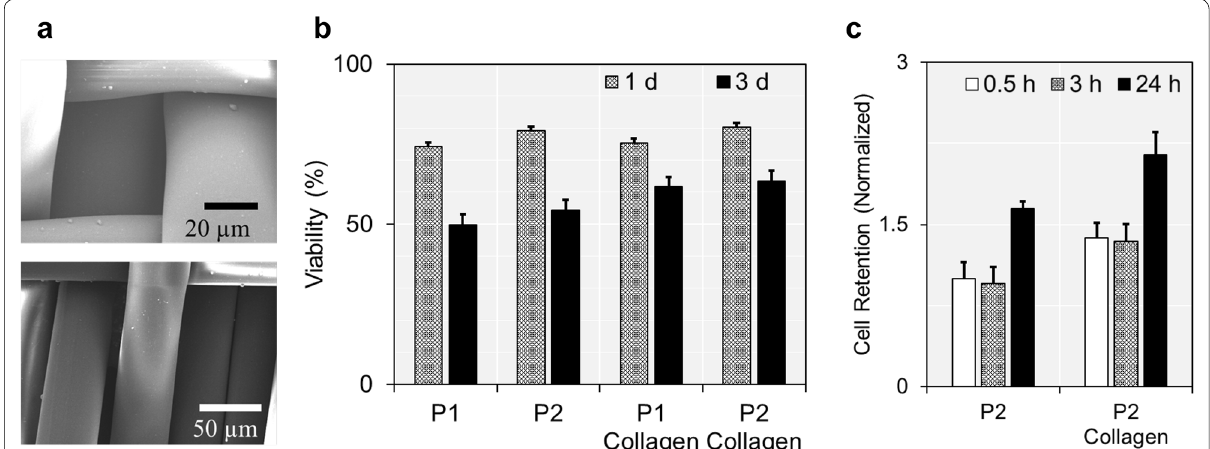
Fig. 2 The fabric filters for the multi‑modal screening of CTCs: a two different fabric filter prototypes, P1 (top) and P2 (bottom), were utilized in this study. The images were obtained using SEM. b , c The viability of cells loaded on different fabric filter prototypes was quantitatively measured, in order to determine the prototype which could minimize the damage on cells during/after cell capture. Cells on collagen coated P2 showed the highest cell viability among the